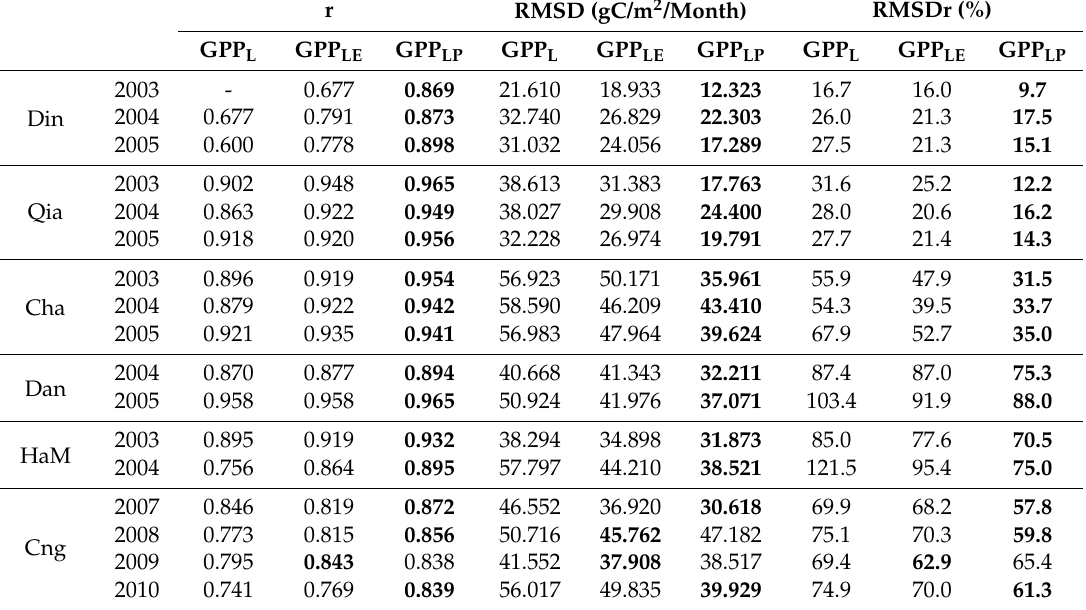
Bold numbers represent the optimal results among GPP L , GPP LE and GPP LP